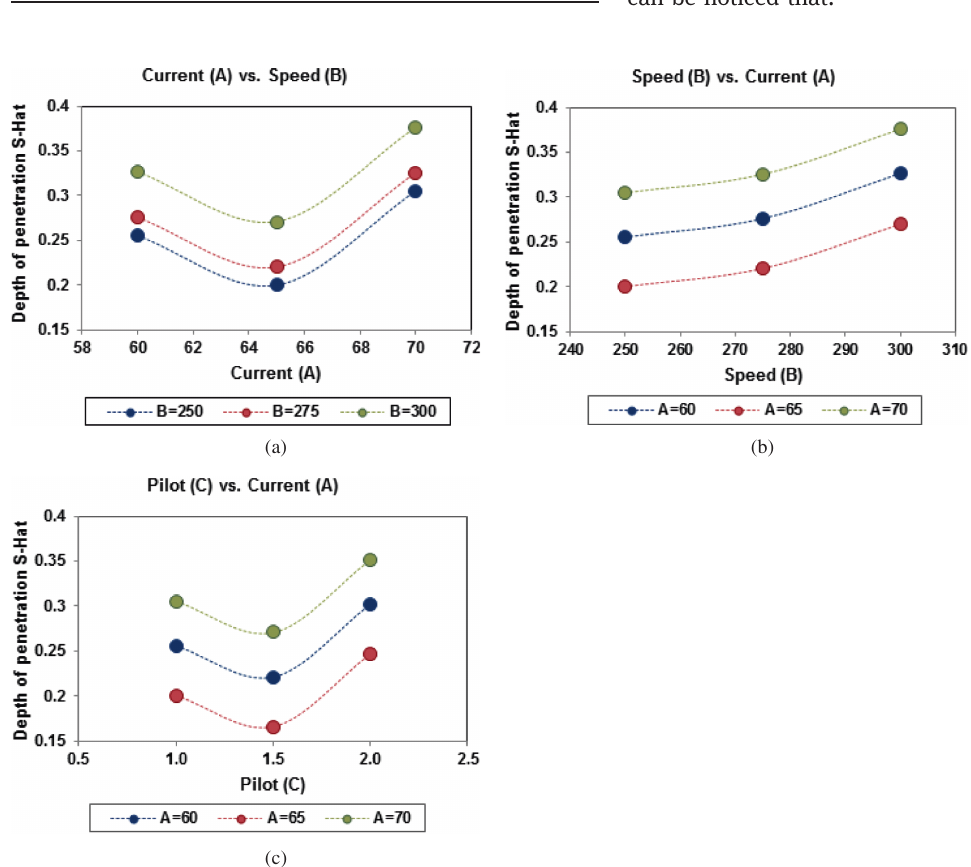
Figure 4: Effect of welding current, welding speed and pilot arc length on the depth of penetration